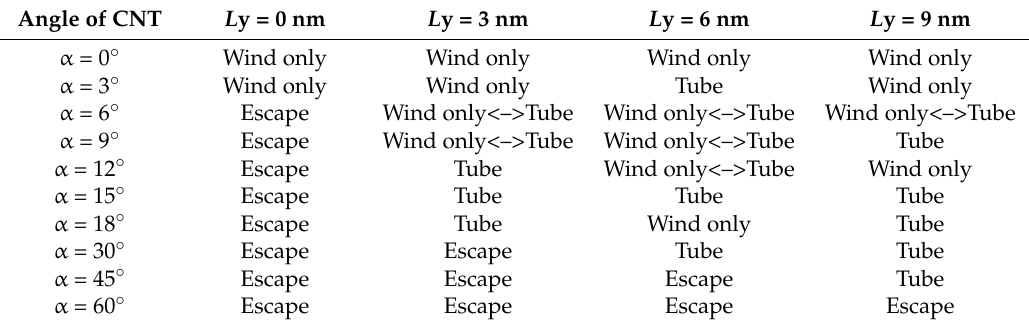
Table 4. Final states of the BP structures with CNT (10, 10) at different angle ( α > 0°) with the z -